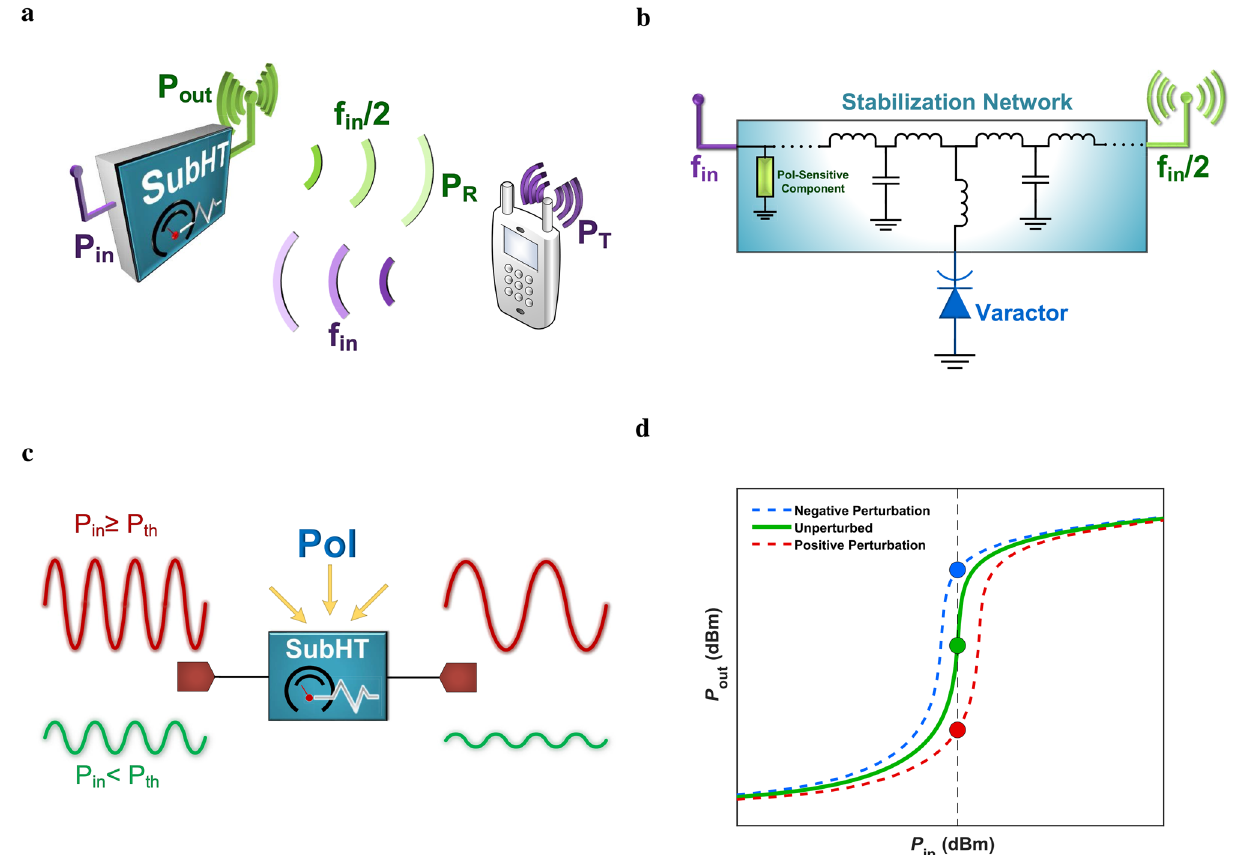
Figure 1. A Sub-Harmonic Tag (SubHT) and its unique operational features. ( a ) Schematic of an envisioned SubHT-enabled wireless sensing architecture. It allows to passively and remotely sense any targeted PoI s. Also, the sensed information is radiated back from the SubHT towards the interrogating node by using a passively generated carrier frequency ( f in /2) that is half of the interrogating frequency ( f in ). ( b ) Circuit schematic representation of a generic SubHT. This includes a varactor and a passive network of off-the-shelf lumped components acting as a stabilization network for the large-signal periodic regimes driven by the portion ( P in ) of the power transmitted by the interrogation node ( P T ) that is received by the SubHT. Also, this network embodies one component that is sensitive to the specific PoI and that is responsible for the activation of the unique dynamics leveraged by the SubHT to sense the PoI . ( c ) A graphic representation of the typical input and output signals characteristics of a SubHT, for input power levels ( P in ) lower (in green) or higher (in red) than the SubHT parametric power threshold ( P th ). ( d ) Typical output power ( P out ) versus P in characteristic of a SubHT when not perturbed (in green) by the PoI or, alternatively, when subject to a positive (in red) or negative (in blue) variations of the PoI